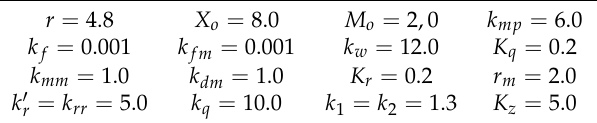
Table 1. Dimensionless parameter